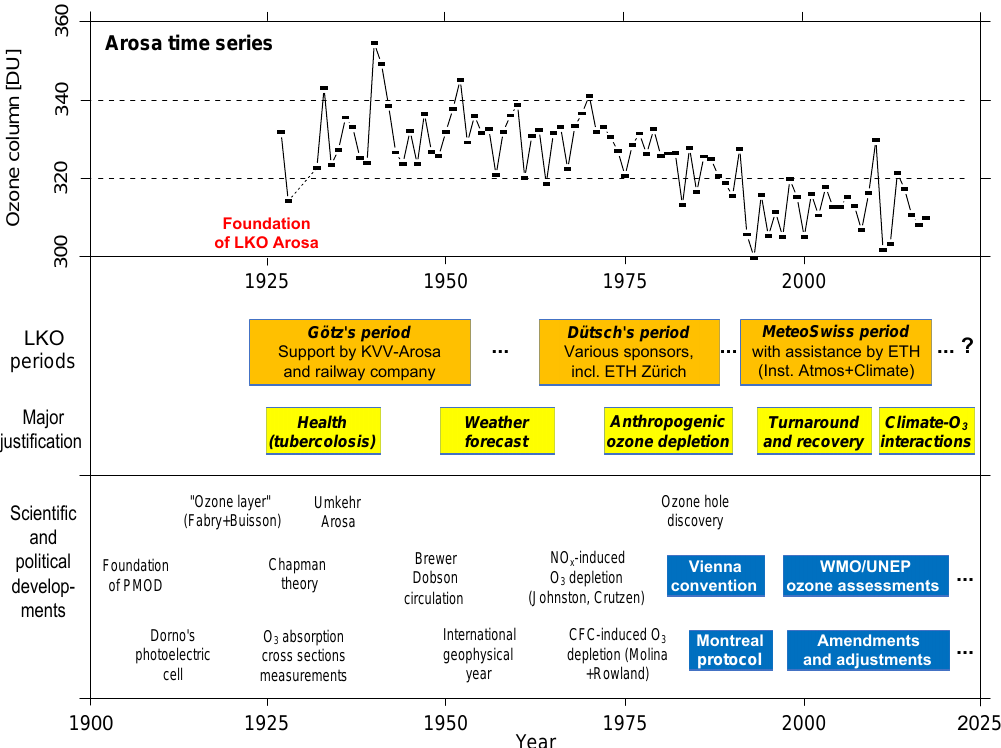
Figure 9. Historical overview of the successive periods of the Light Climatic Observatory of Arosa (LKO). Total ozone measurements (top, annual means); different phases during the history of LKO including main sponsors (in orange); justification of measurements for society (in yellow); milestones in international ozone research and international legislation